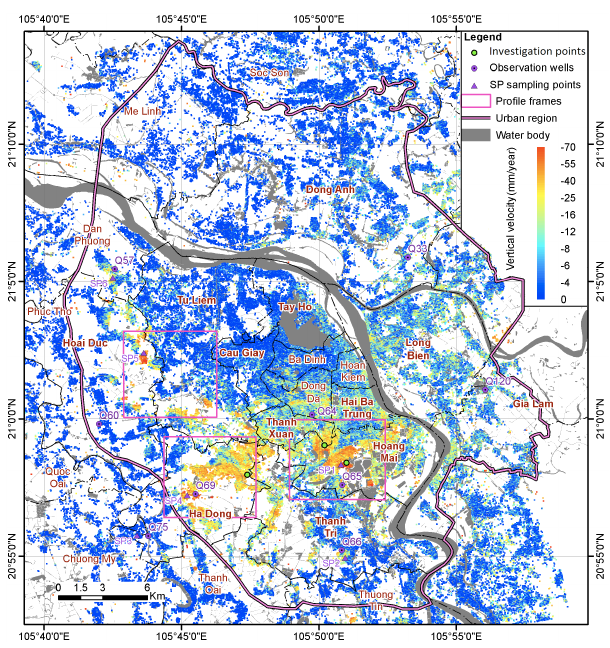
Fig. 3. Averaged vertical subsidence velocity in urban region of Hanoi (location in Fig. 1) issued from InSAR processing for the period February 2007–February 2011. Red boxes are the locations for Fig.